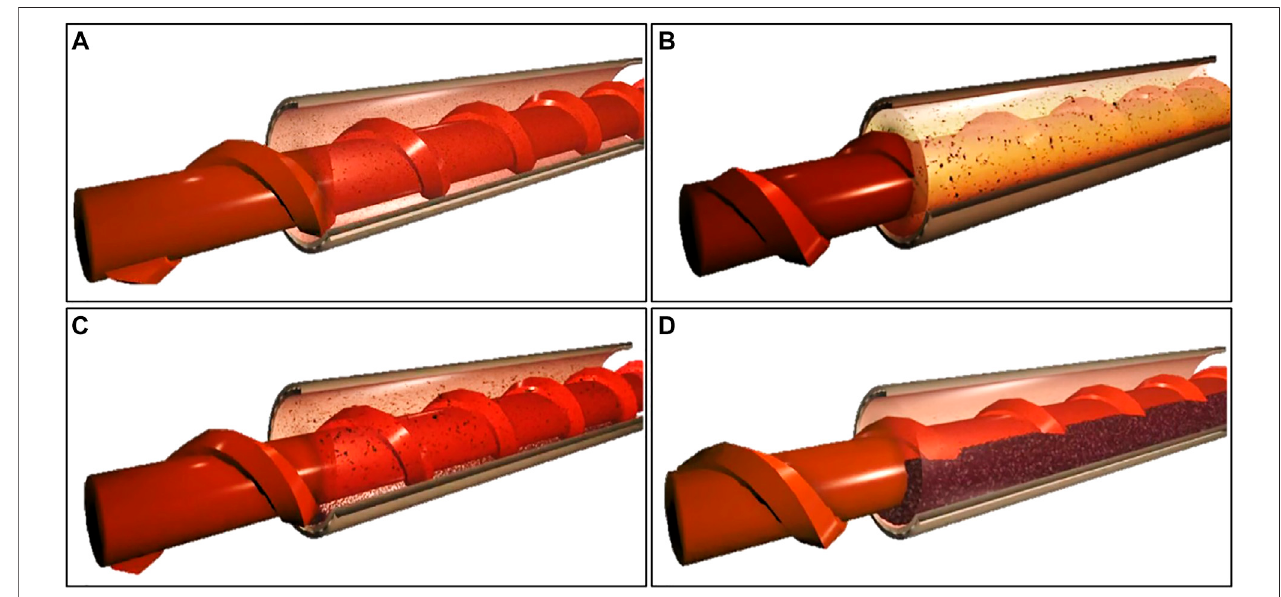
FIGURE 1 | The annular solid-liquid fl ow model. (A) Homogeneous suspended state; (B) Inhomogeneous suspended state; (C) Moving laminar fl ow regime; (D) Fixed laminar fl ow regime.